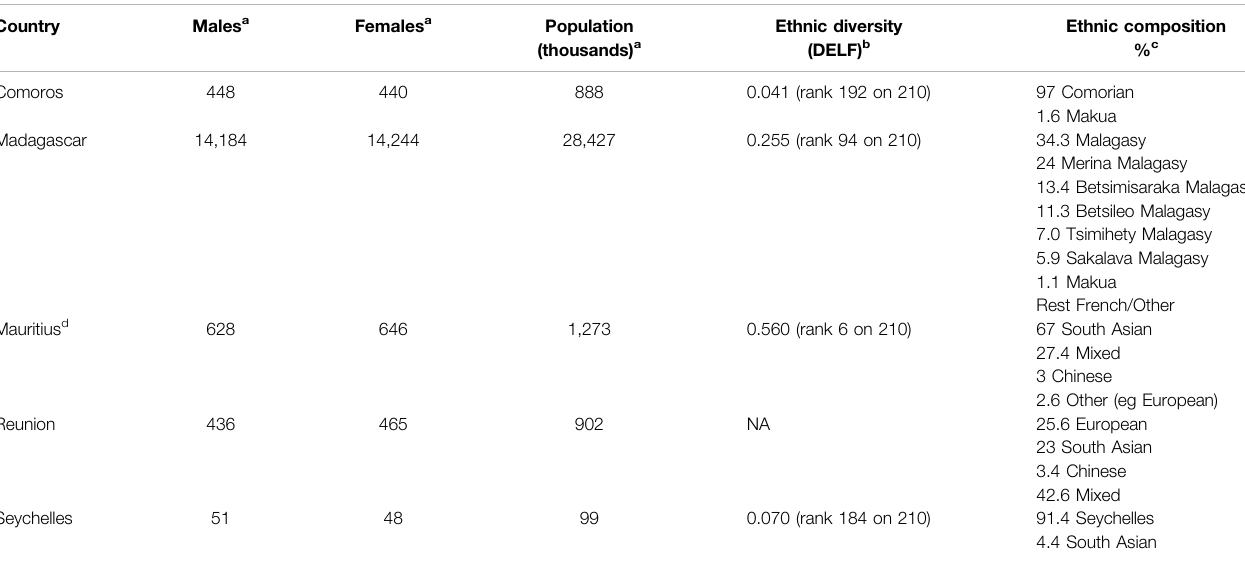
TABLE 1 | Population